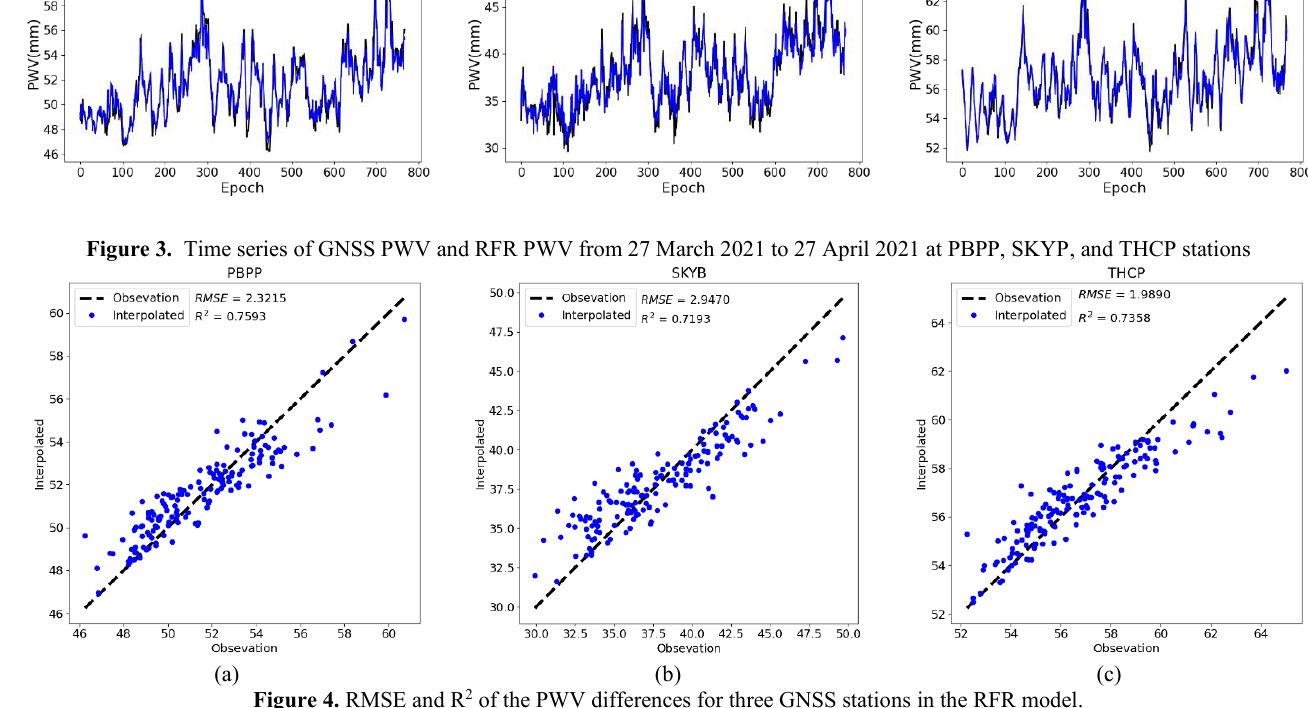
Figure 4. RMSE and R 2 of the PWV differences for three GNSS stations in the RFR